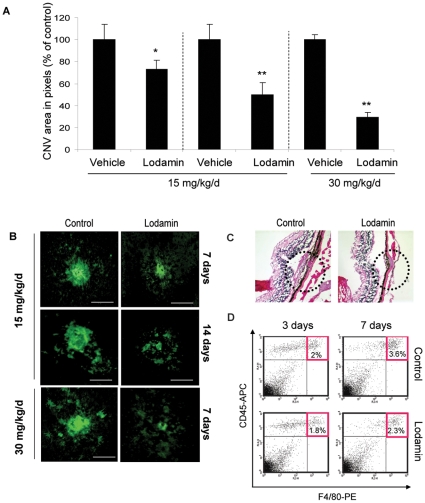
Oral treatment of Lodamin reduces CNV progression.(A) CNV lesion size of Lodamin-treated mice compared to controls. A dose of 15 mg/kg/day was administered for 7 or 14 days and a dose of 30 mg/kg/day was administered for 7 days. CNV lesions in choroidal flat mounts were evaluated after staining of blood vessels using isolectin-IB4 conjugated with Alexa Fluor 488. Data are presented as percent of blood vessel area in choroidal flat mounts (pixels) of treatment per controls. Data are expressed as mean ± SEM, (U-test, * P<0.05, ** P<0.005, n = 10). (B) Representative images of CNV lesions stained with a lectin-FITC in flat mount of mouse choroids. Bar = 20 µm. (C) H&E stained histological side sections of CNV site in Lodamin treated or untreated mice. Substantial differences in fibrous tissues thickness and choroidal vessel invasion to CNV site are detected, Bars = 50 µm (D) FACS analysis of single-cell suspension originated from retinas after 3 and 7 days of oral Lodamin treatment. Quantification of macrophage infiltration in mouse retinas originated from Lodamin treated (30 mg/kg, daily, oral) or mice which were treated with equivalent dose of vehicle. Macrophage population was detected as a double positive CD45+ and F4/80+ staining.